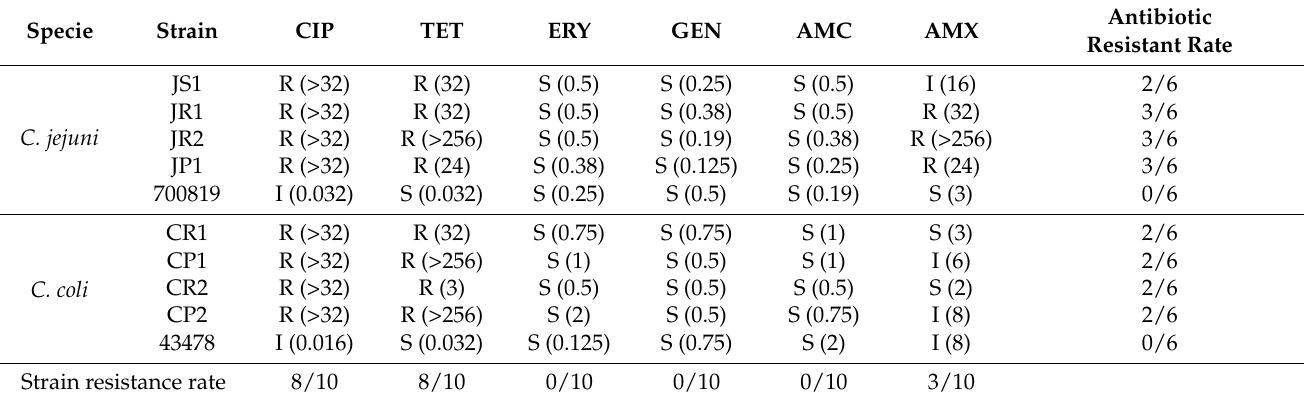
Table 1. Antibiotic susceptibility profile and minimal inhibitory concentration (MIC) values for the Campylobacter spp.